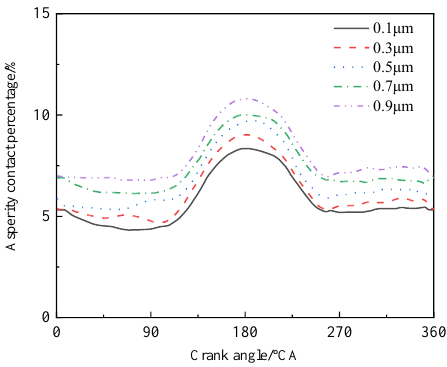
0 Figure 14. Asperity contact percentage in different bushing Figure 14. Asperity contact percentage in different bushing roughnesses.